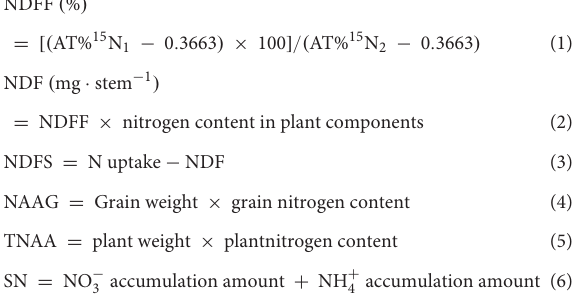
Frontiers in Plant Science |